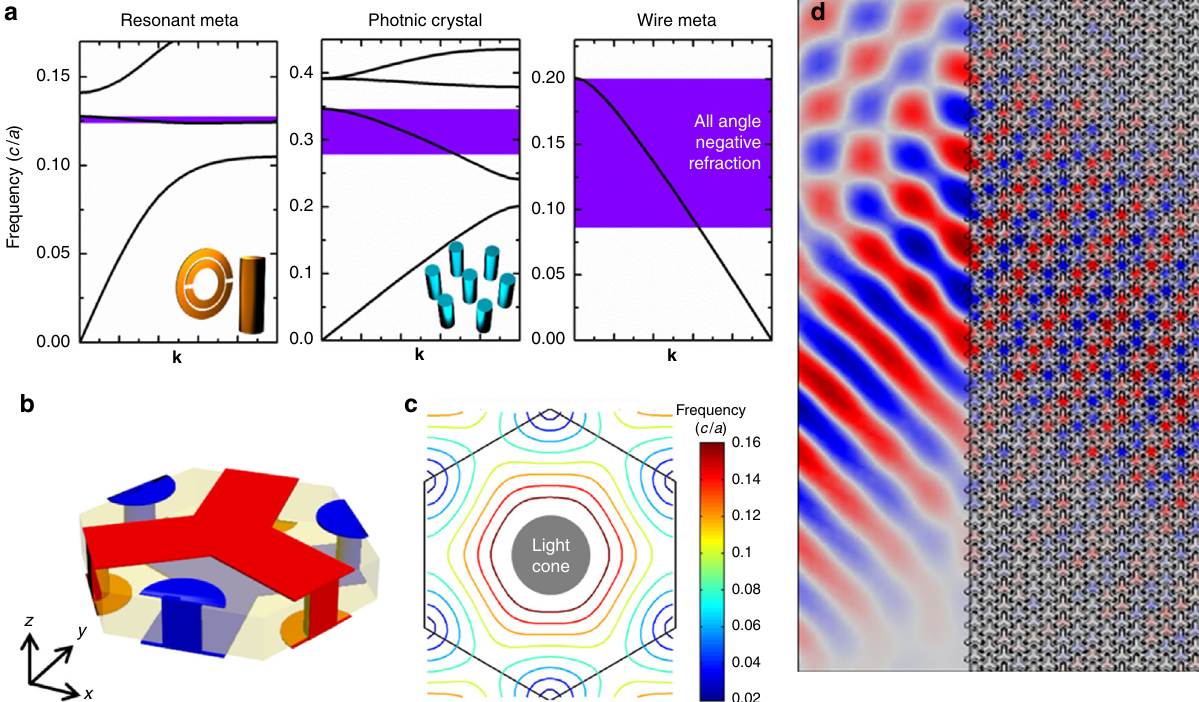
Fig. 7 Broadband-negative group velocity medium. a Prototypical dispersions of resonant metamaterials, photonic crystals and wire metamaterials. The negative index of resonant metamaterials (in this case a split-ring resonator [Ref. 3]) relies on the built-in local resonance and thus works in a narrow frequency range. For photonic crystals [see, e.g., Ref. 50], the negative group velocities appear in the second or higher band and have a limited bandwidth. For metamaterials with bands emerging from nonzero k -points, even the lowest band can exhibit negative group velocity and have broad bandwidth. b Unit cell of a 2D hexagonal metasurface with negative index. c Equifrequency contours of the guided modes in the metasurface. At very low frequencies, the equifrequency contours are six ellipses emerging from the Brillouin zone corners. As frequency increases, these ellipses grow bigger to form a closed contour centered at Γ point from 0.1 to 0.17 c / a with the contour shrinks toward Γ , giving negative group velocities in this frequency regime. The gray solid circle marks the projected light cone. d Simulated fi eld pattern when a plane wave is impinged onto the metasurface from an ordinary material (parallel plate waveguide). Negative refraction is evident. The Gaussian beam with frequency of 0.13 c / a is incident from the lower left with